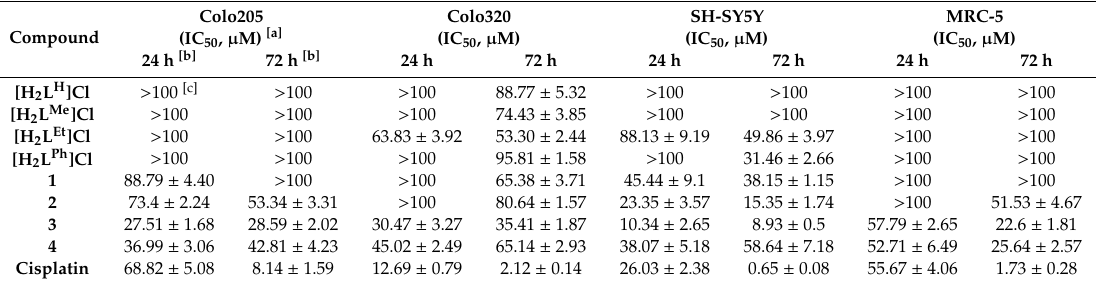
Table 3. IC 50 values after inhibition of cell growth by the proligands [H 2 L R ]Cl and 1 – 4 in